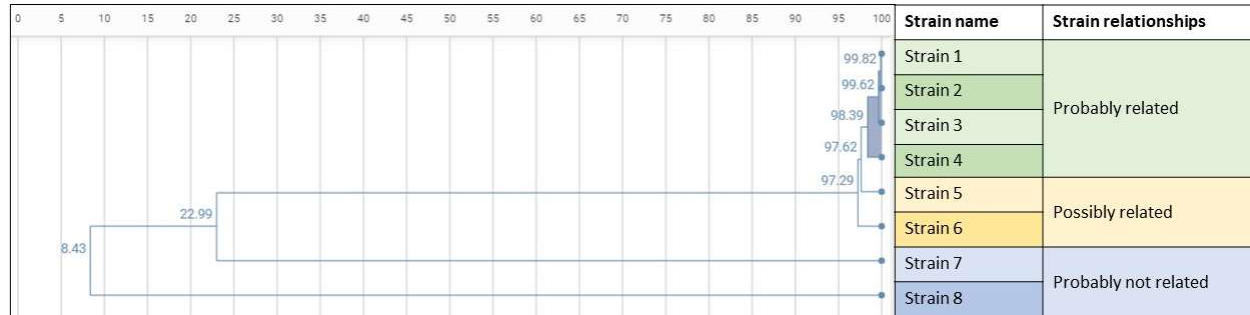
Figure 3. Dendrogram. High and low similarity coefficient cut-offs were established at >98% and 95%, respectively. Four isolates were classified as probably related and formed Cluster 1. Two iso- lates were considered possibly related and another two isolates were considered probably not related.